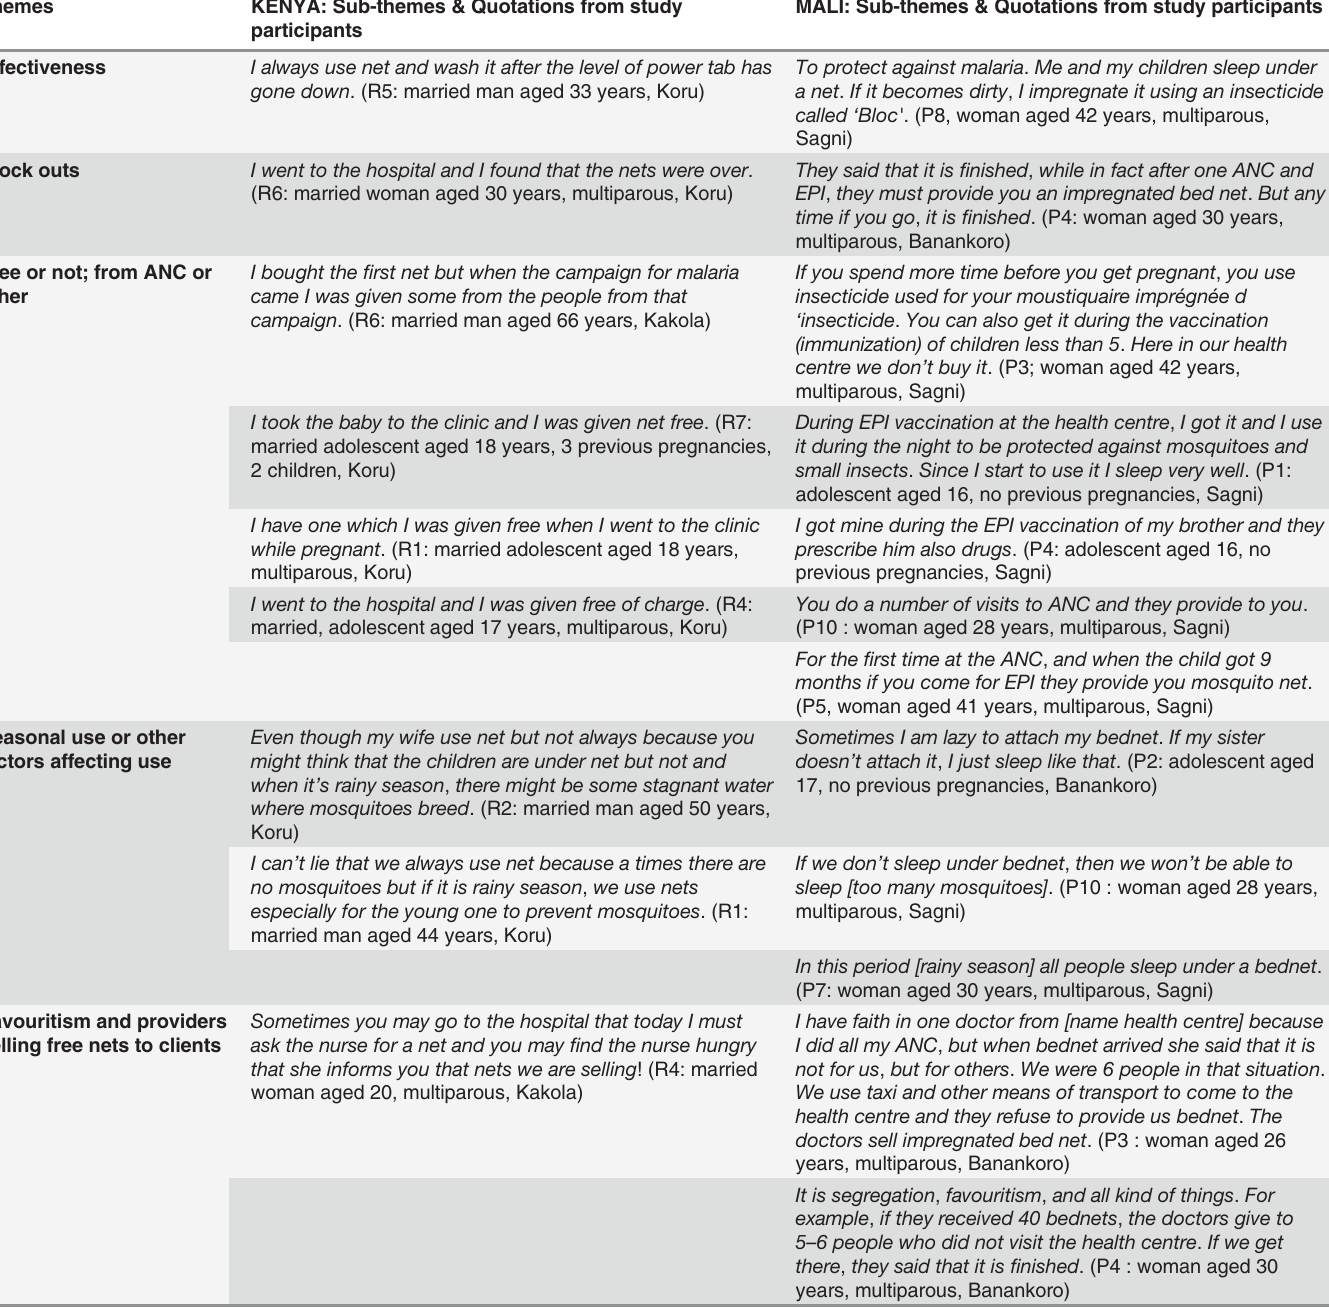
Table 5. Factors affecting pregnant women ’ s practices for the prevention of malaria: